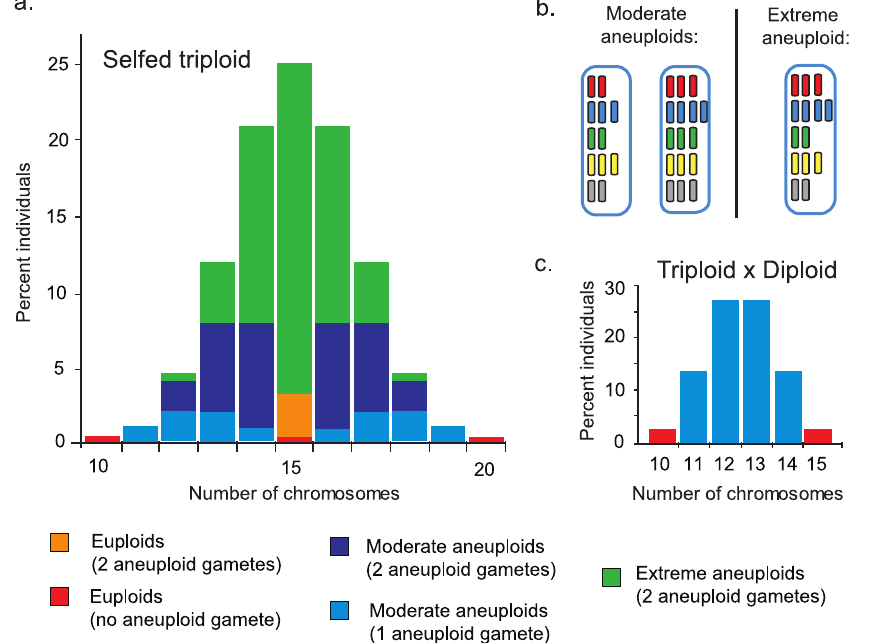
Figure 6. Different Aneuploid Types Found in the Progeny of Triploids (A) The different types of individuals expected in the progeny of a selfed triploid depending on their karyotype and on the karyotype of the gametes that produced them. (B) In moderate aneuploids, the difference in number of copies of different chromosome types is maximum 1. In extreme aneuploids, some chromosome types are present in two (or more) additional copies than other chromosome types. (C) In the progeny of a cross between triploid and diploid individuals, only two types of individuals are found: euploids produced by euploid gametes or aneuploids produced from an aneuploid gamete and a euploid gamete.